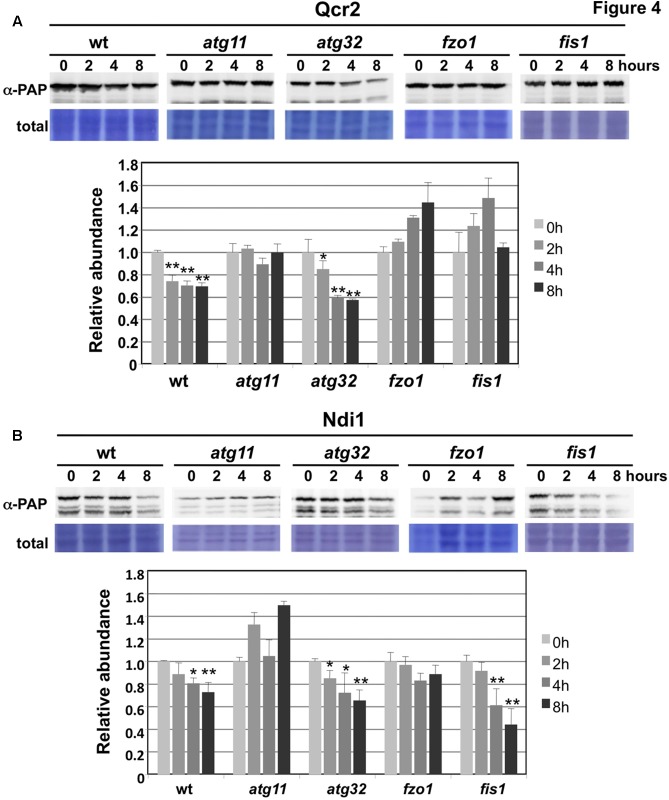
Degradation of CI and CIII subunits upon mitochondrial damage is dependent on Atg11 and mitochondrial fusion/fission, but independent on Atg32. Experimental conditions were the same as in Figure 3. (A) CIII subunit Qcr2 degradation upon valinomycin treatment in wild type and the indicated deletion mutants. Data are shown as mean values from three independent experiments including the standard error. (B) Ndi1 degradation upon valinomycin treatment in wild type and the indicated deletion mutants. Data are shown as mean values from three independent experiments including the standard error. Significantly different degradation rates are marked: ∗p < 0.05; ∗∗p < 0.01 (Student’s t-test).